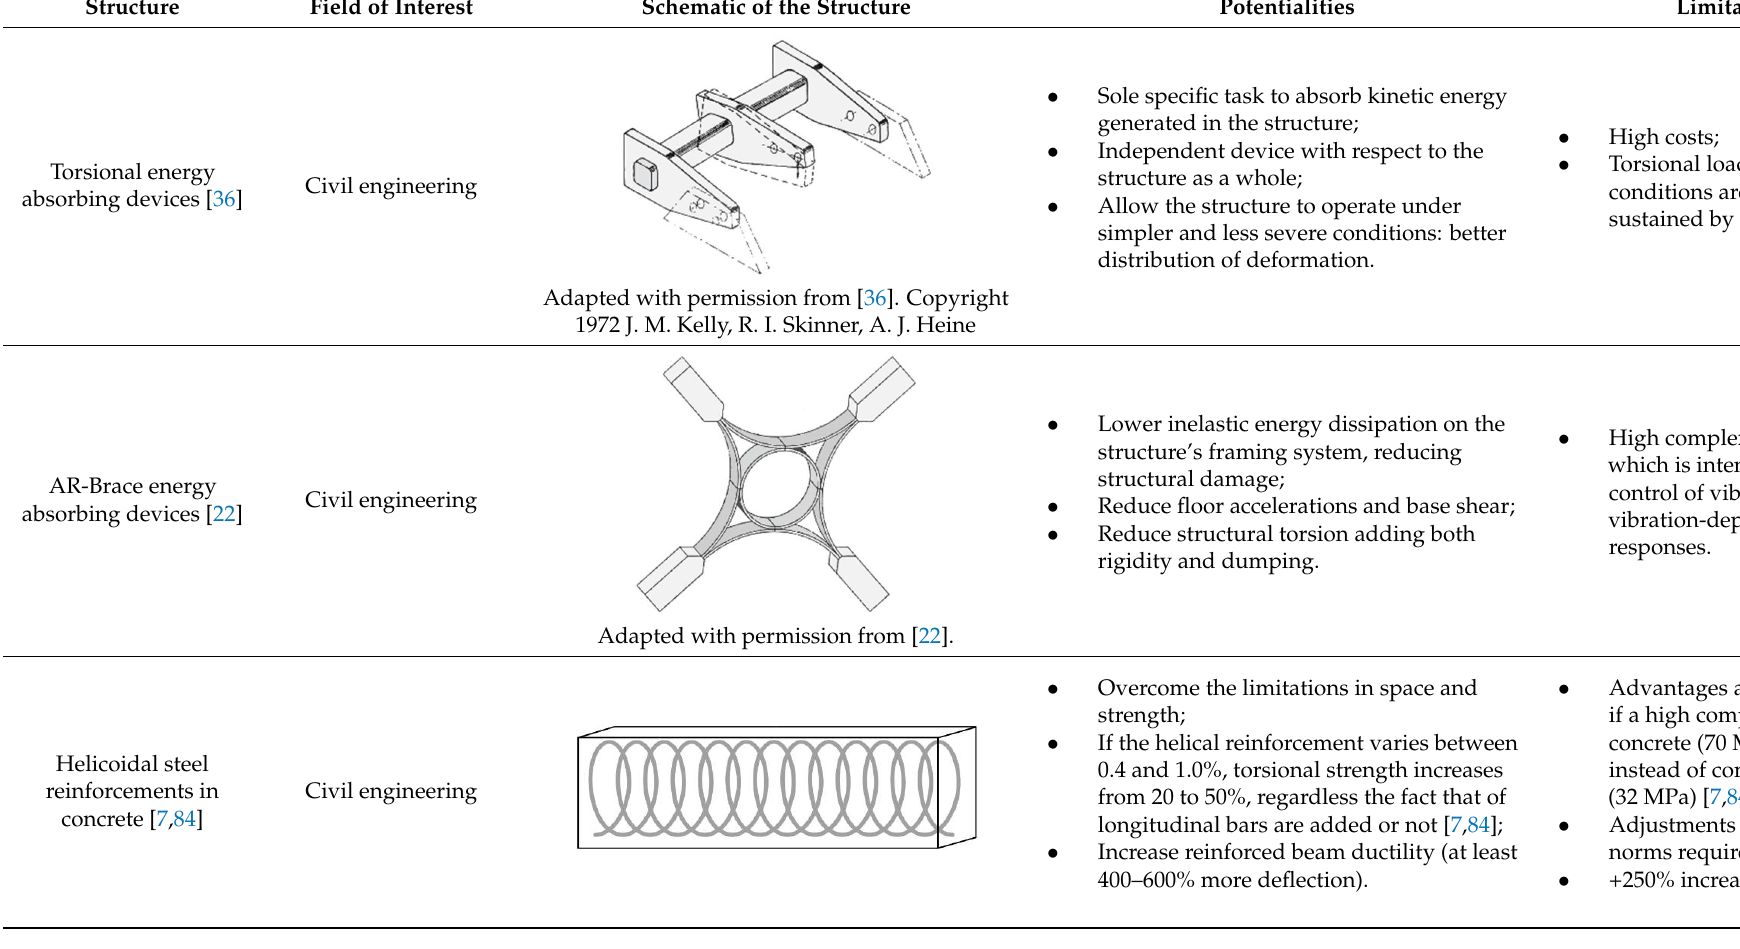
Table 1. Common-designed torsion resistant structures. In the table, the fields of interest, a schematic of torsion-resistant components, their potentialities, and limitations are highlighted. Structure